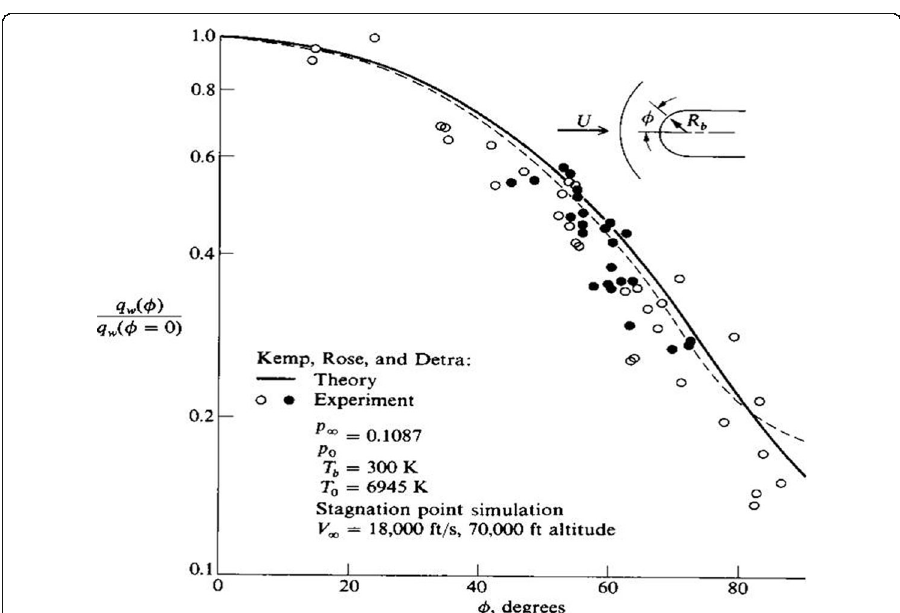
Fig. 3 Stagnation point heat transfer by compressible similar boundary-layer